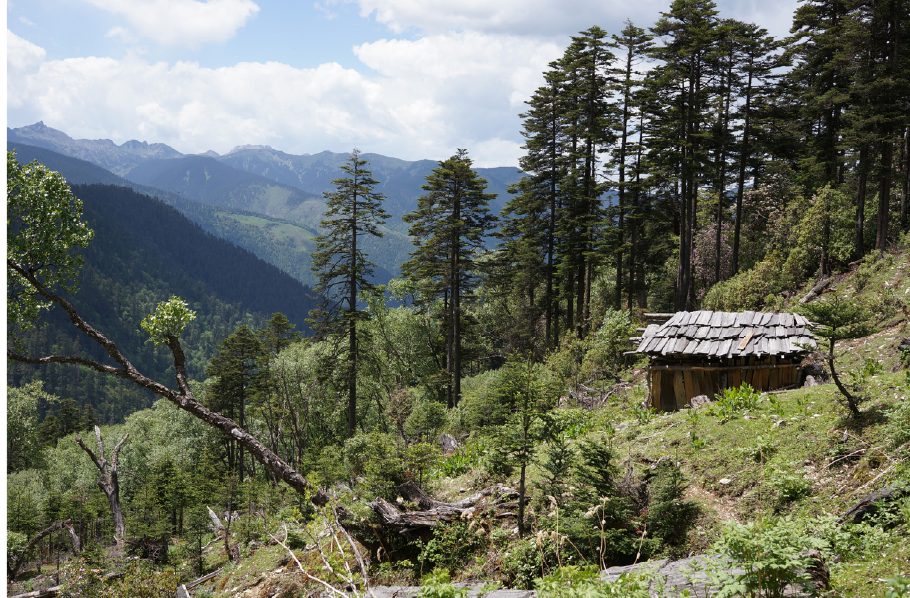
Figure 12. Chrysolina igori sp. nov., type locality. Photo by I.A. Belousov. Type locality. China, NW Yunnan, Deqen, Tuoxia Highway, Mt. Range between Xiaruolisuzuxiang and Yezhizhen 27°42 ′ 50” N/99°11 ′ 27” E Description. Holotype (male). Body, broadly oval, convex. Dorsal side, dark bronze. Antennae, black with antennomeres 1 and 2 rufous below apically. Legs, entirely black. Head and pronotum sericeous, shining, shagreen and micropunctulate, elytra very shin- ing, smooth,